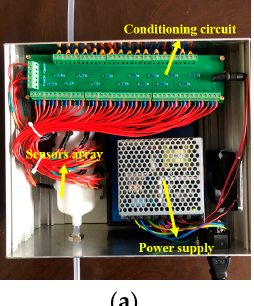
Figure 1. ( a ) EN physical diagram; ( b ) Schematic diagram of the EN structure. Table 2. Sensors in the sensor array. Sensor Target Gases methane, propane, butane